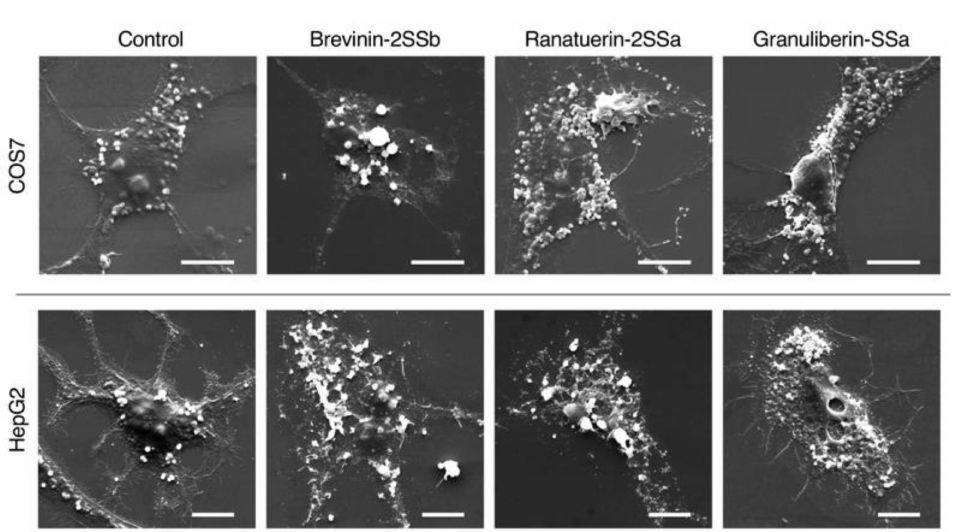
Figure 9. Scanning electron microscopy (SEM) analysis of mammalian cells following treatment with brevinin-2SSb, ranatuerin-2SSa, and granuliberin-SSa. Aliquots of COS7 or HepG2 cells were incubated with brevinin-2SSb, ranatuerin-2SSa, granuliberin-SSa, or myoglobin (control) at 32 µ g / mL for 24 h at 37 ◦ C and were then examined using SEM analyses. Cell-membrane destruction is visible in each panel of brevinin-2SSb-, ranatuerin-2SSa-, and granuliberin-SSa-treated cells when compared with control (0 dose) cells. Scale bars represent 10 µ